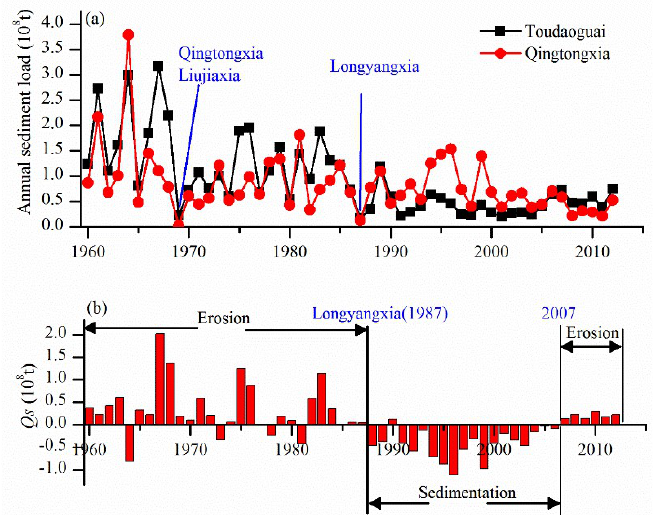
Figure 8. Variations of sediment load recorded at the Qingtongxia and Toudaoguai stations: ( a ) variations of annual sediment load; and ( b ) difference in sediment load between the Qingtongxia and Toudaoguai stations (the positive value means the annual sediment output is larger than the sediment input, whilst the negative value means the annual sediment input is larger).